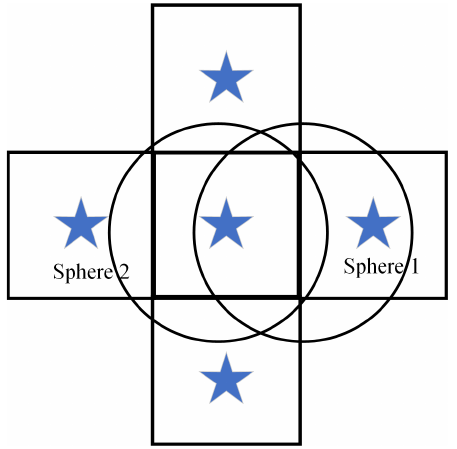
Figure 2. A counter-example to average volume.